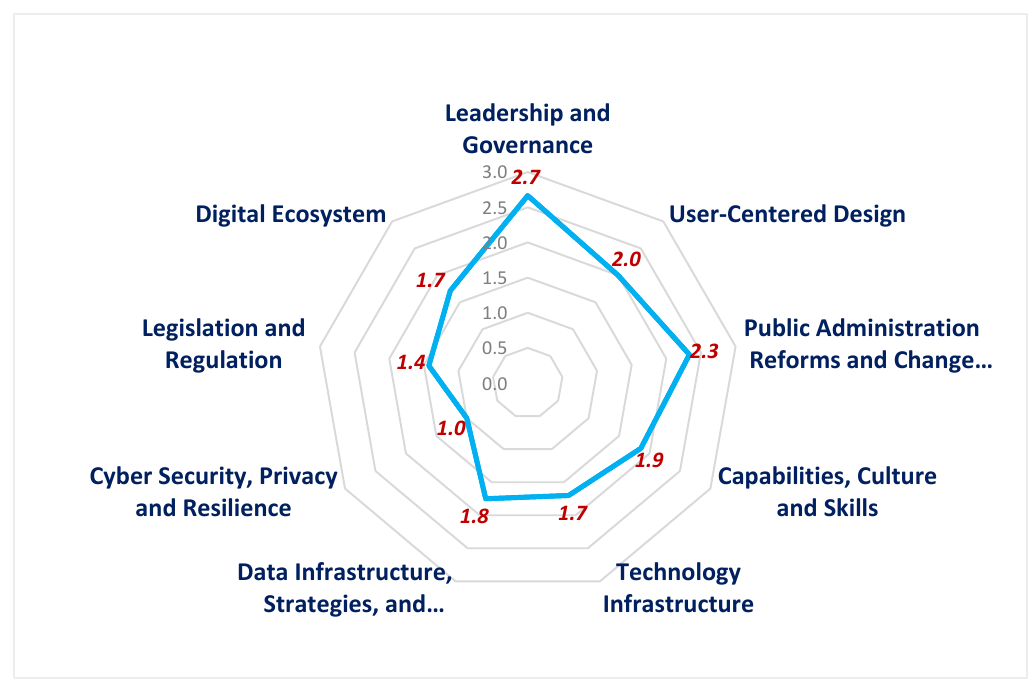
Figure 6. The digital government readiness score per section for land services in the Ministry of ATR/BPN.